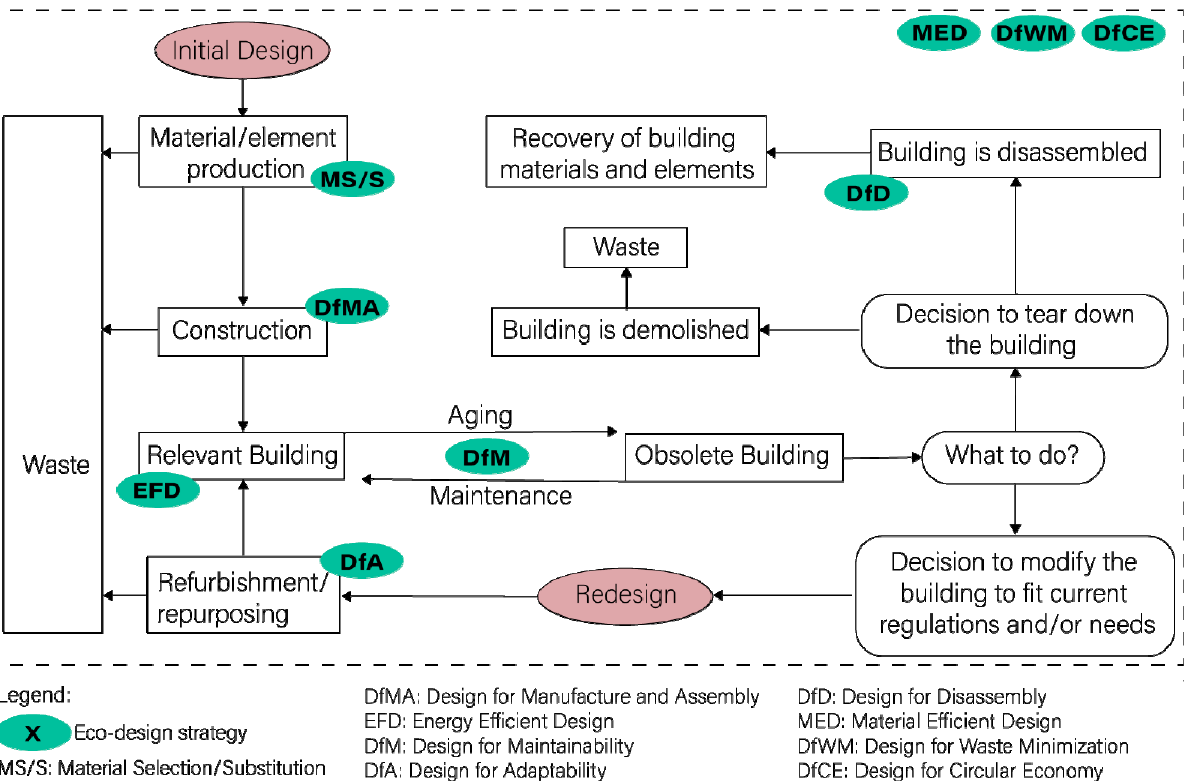
Figure 6. The design strategies relevant for eco-designing buildings based on the review literature. The strategies are placed by the building lifecycle stage they concern and can potentially affect the most.